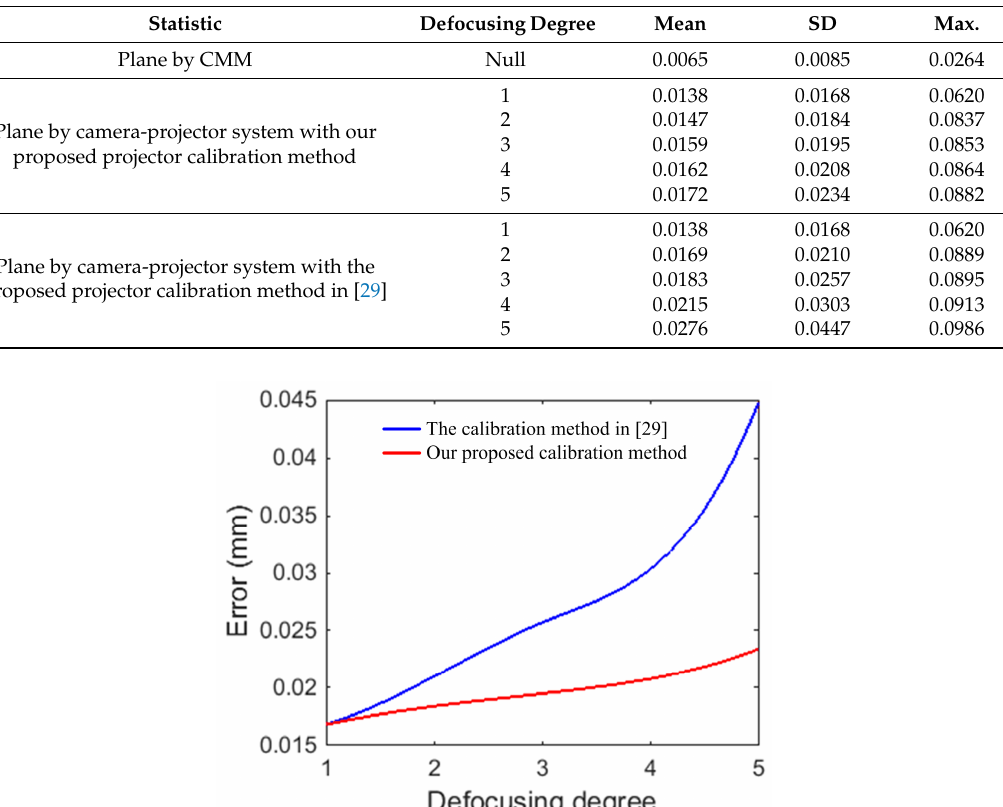
Figure 17. Measurement results and error of plane under different defocusing degrees: ( a ) fitting plane; ( b ) measurement error of the plane under defocusing degree 1 (projector in focus); ( c – f ) measurement error of the plane under defocusing degree 2–5 by our proposed calibration method; ( g – j ) corresponding the measurement error of the plane under defocusing degree 2–5 by the calibration method in [29]. Table 5. Statistics of the measurement results of plane (unit: mm). Table 5. Statistics of the measurement results of plane (unit: mm).